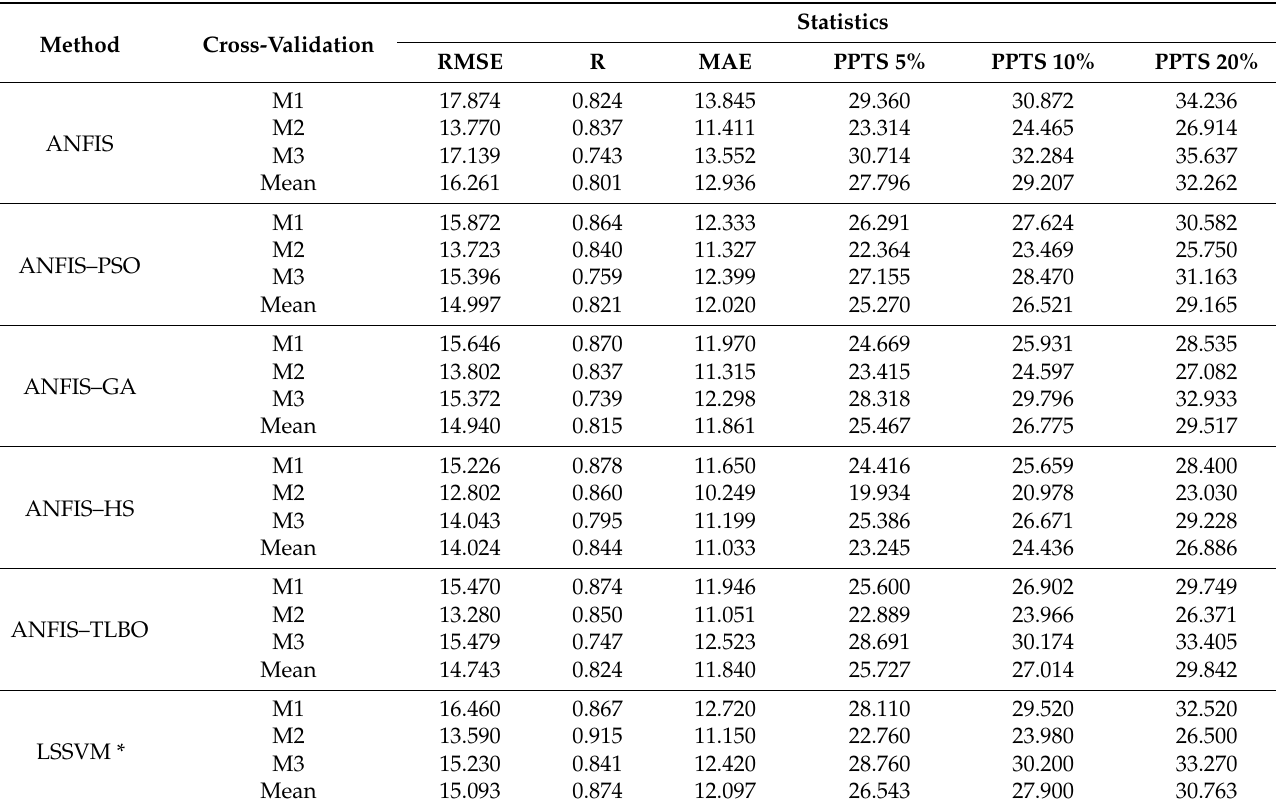
Table 5. Comparison of models’ performance with AMM, TKN, and WT as inputs.